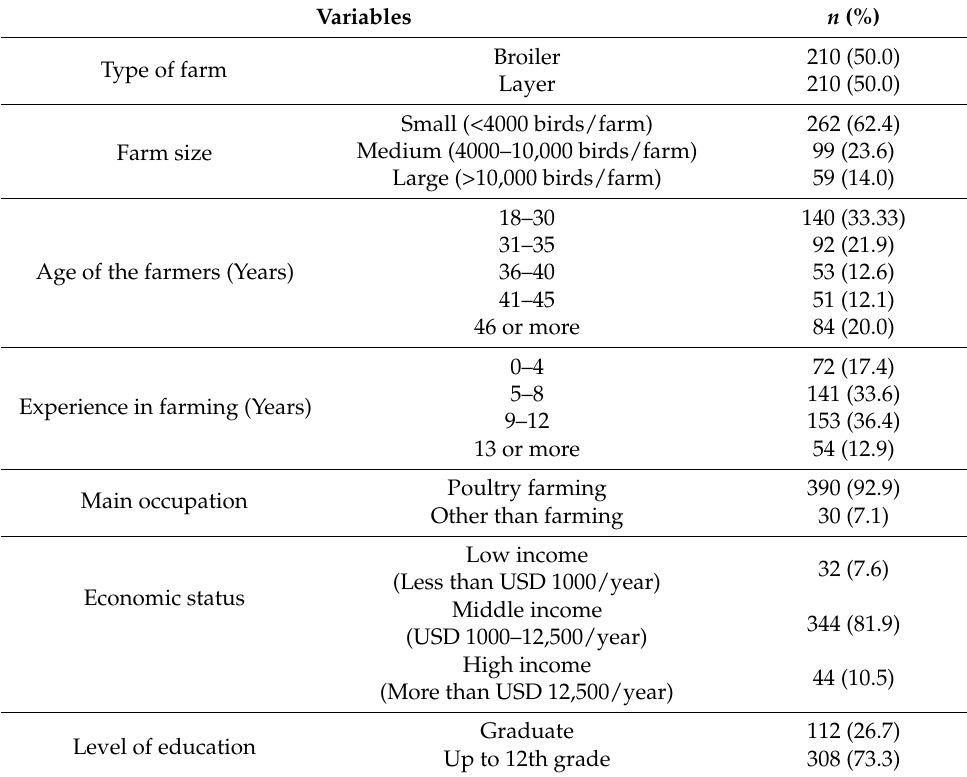
Table 1. Demographic and socioeconomic information of the